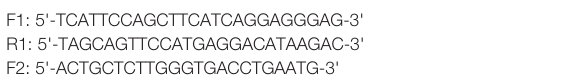
TABLE 1 | Primer sequences for